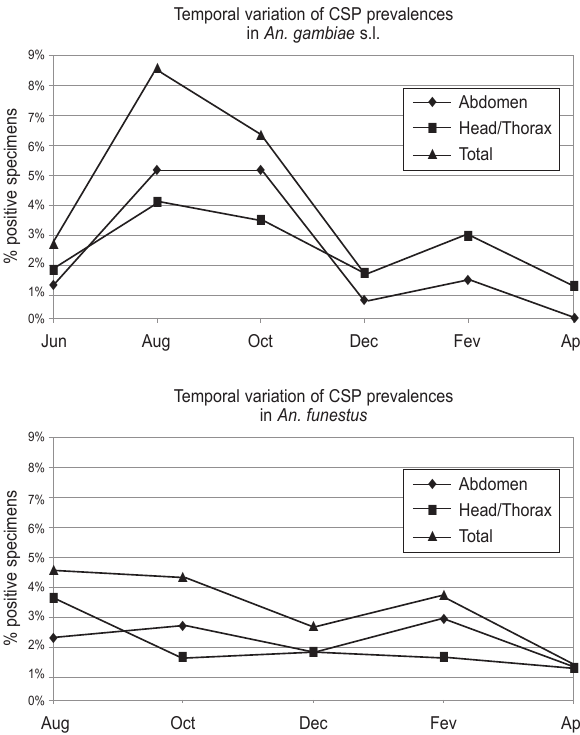
Fig. 1. – Temporal variation of the prevalence of CSP by ELISA method in different portions of samples of the two malaria vectors An. gambiae s.l. (top) and An. funestus (bottom). Squares: CSP in head and thorax, diamonds: CSP in abdomen, triangles: specimens positive either in abdomen or